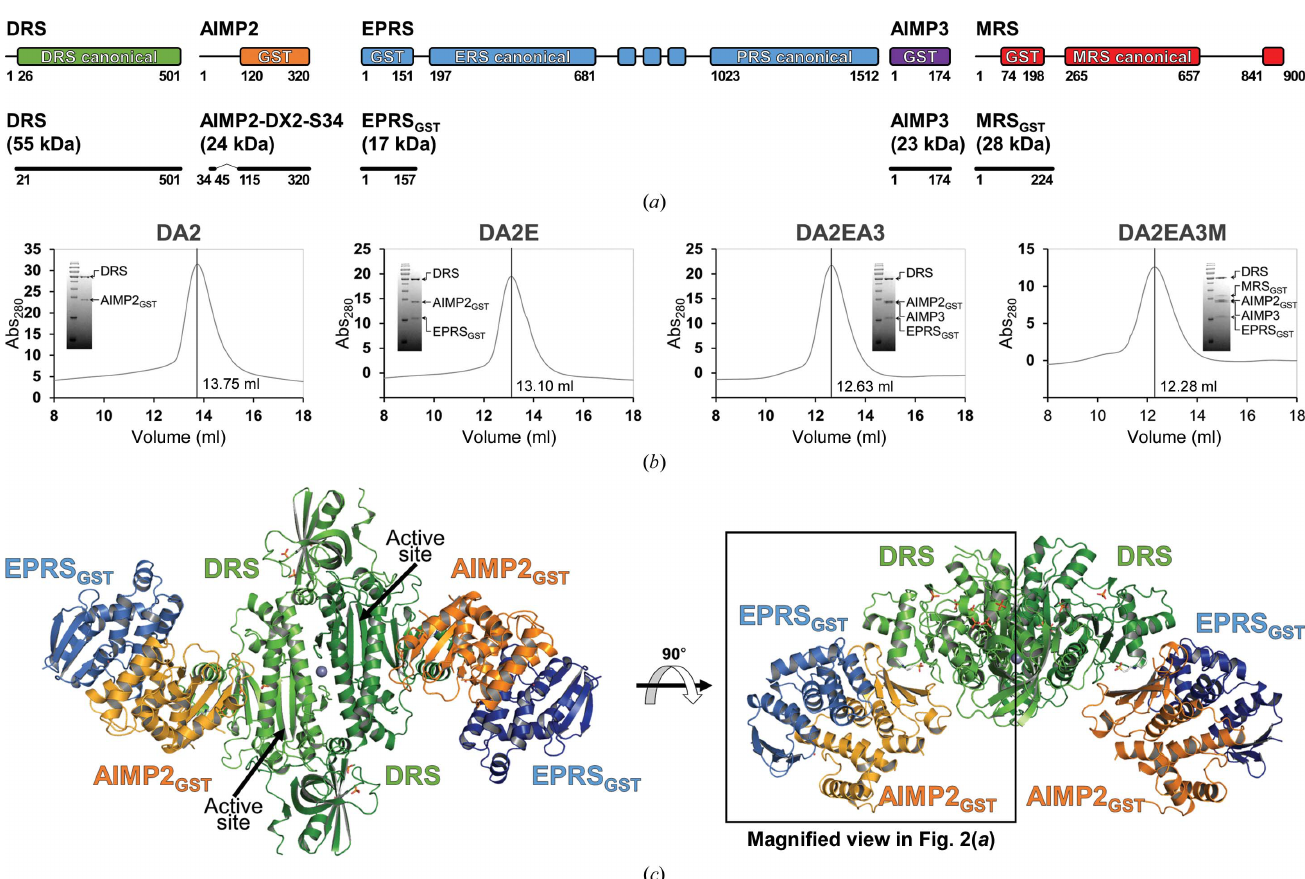
Figure 1 Structure and assembly of the DRS–AIMP2 GST –EPRS GST subcomplex of the MSC. ( a ) Domain compositions of DRS, AIMP2, EPRS, AIMP3 and MRS (top), and representations of the constructs used in this study (bottom). ( b ) Size-exclusion chromatography analyses of the MSC subcomplexes DA2, DA2E, DA2EA3 and DA2EA3M. Inset: SDS–PAGE analysis of the highest peak. ( c ) Left: overall view of the crystal structure of the DA2E subcomplex of the MSC in cartoon representation. DRS (green), AIMP2 GST (orange), EPRS GST (blue) and a Zn atom (gray) are shown. Right: the DA2E structure is horizontally rotated by 90 (cid:3) , showing the interfaces among the components. Phosphate ions are represented as stick models. (See also Supplementary Fig.